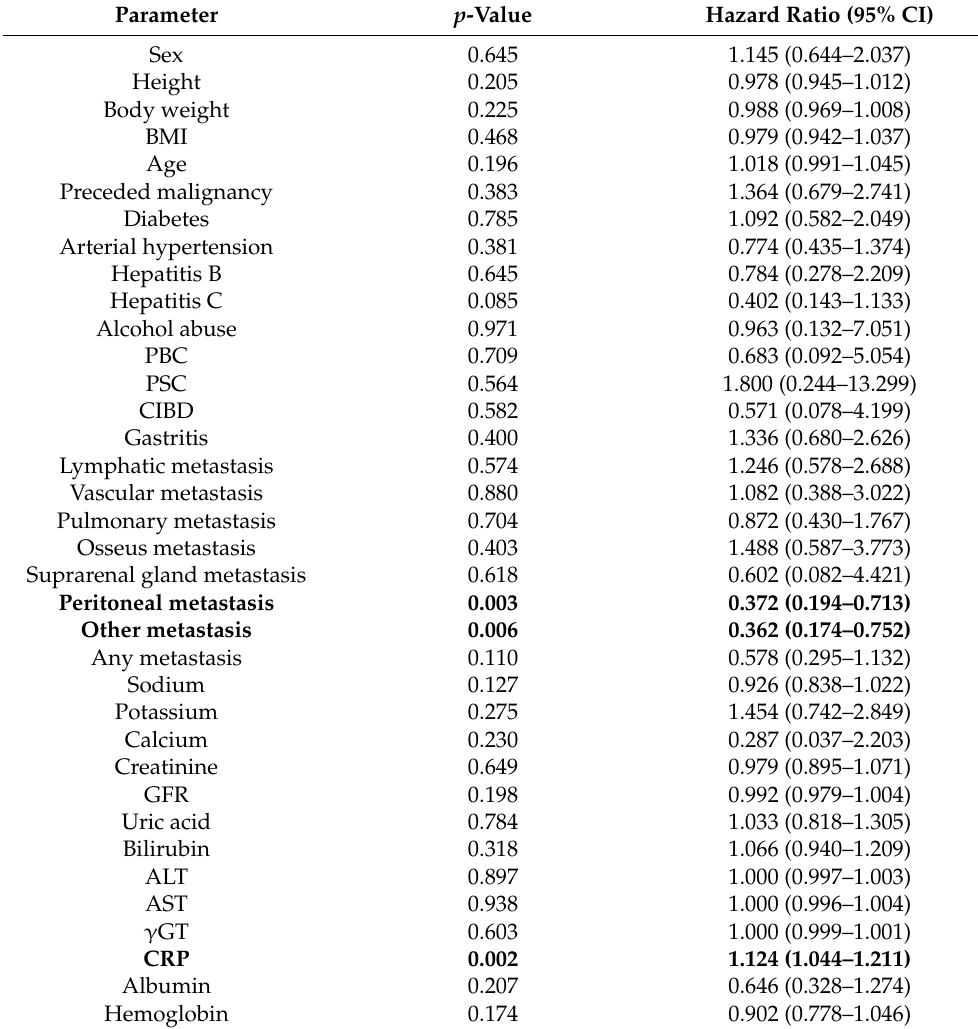
Figure 4. L3SMI and L3PMI are predictors of overall survival in CCA patients under palliative therapy. ( A ) CCA patients with an L3SMI value below the calculated ideal prognostic cut-off value of 71.95 mm 2 /cm show a significantly reduced overall survival compared to patients with an L3SMI above the cut-off. ( B ) CCA patients with an L3PMI value below the calculated ideal prognostic cut-off value of 6.345 mm 2 /cm show a significantly reduced overall survival compared to patients with an L3PMI above the cut-off. Table 2. Univariate Cox regression analysis for the prediction of overall survival.